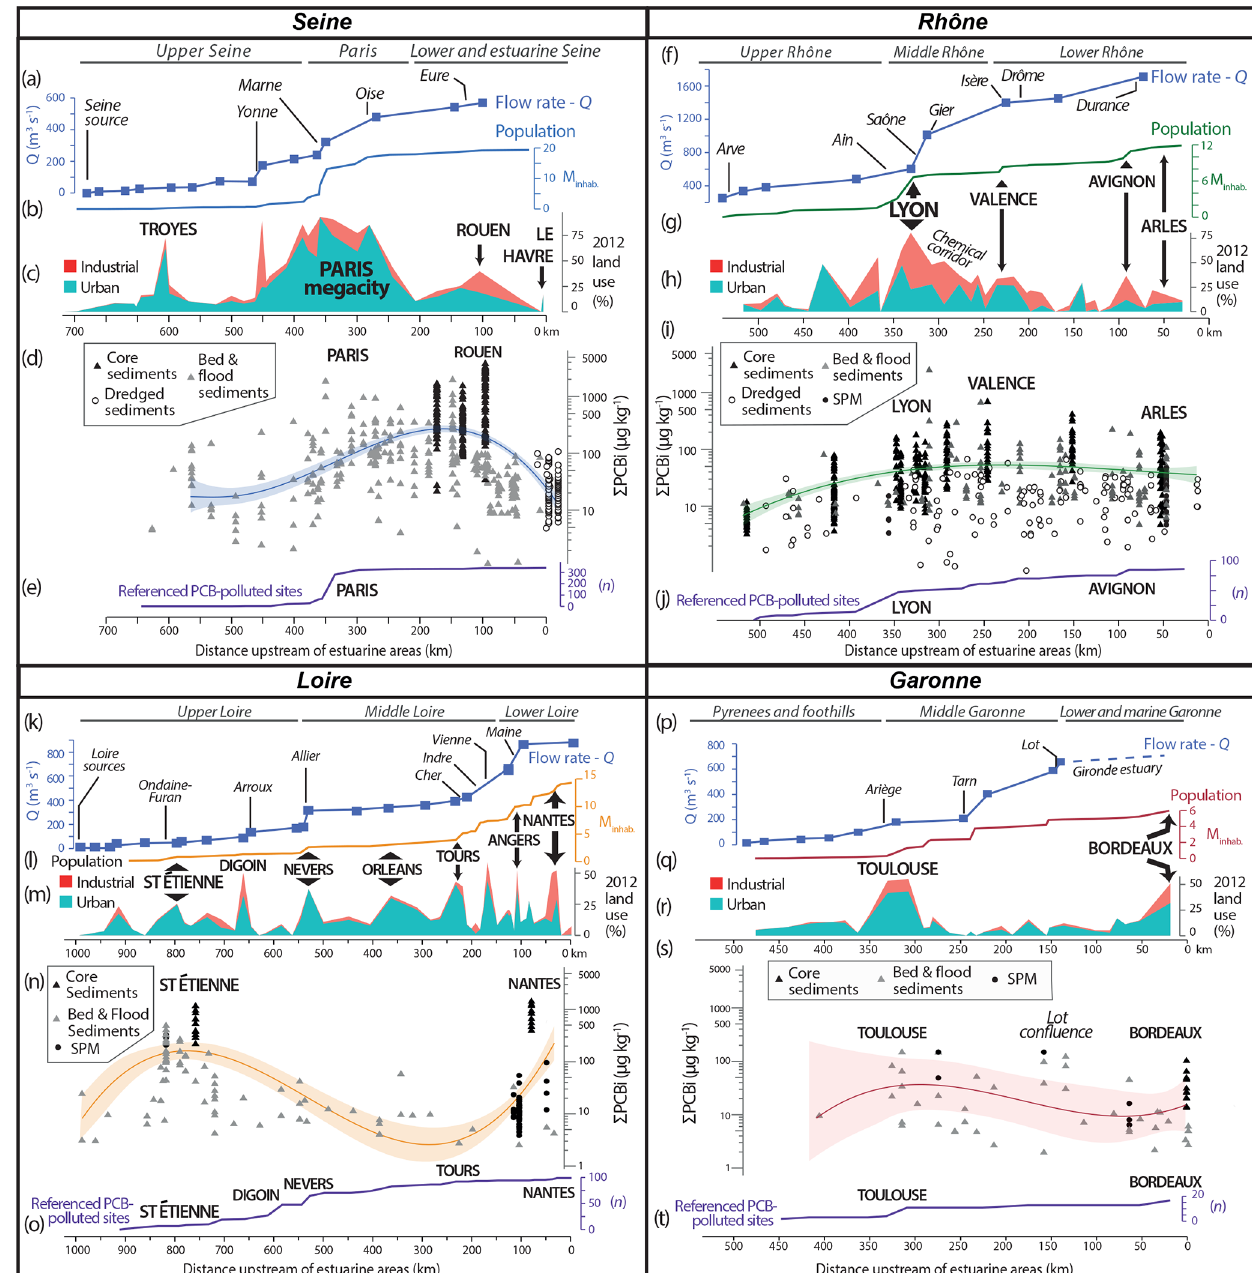
Figure 2. Main physical and socio-environmental information computed along each river corridor: (a–e) Seine, (f–j) Rhône, (k–o) Loire and (p–t) Garonne. River discharges and their main tributaries are plotted in (a) , (f) , (k) and (p) . Cumulative population in the watershed (expressed in millions of inhabitants – M inhab . ) is represented in (b) , (g) , (l) and (q) . The main urban and industrial areas within 1km of the riverbed are shown with stacked area charts in (c) , (h) , (m) and (r) . (cid:54) PCBi in solid matrices are plotted all together according to a GAM to represent the spatial variability in the PCB stocks during the period 1945–2018 ( d , i , n and s ). PCB-polluted sites referenced by the BASIAS and BASOL databases are represented by a curve cumulating the number of sites in the downstream direction ( e , j , o and t ). The distance scale is expressed in kilometres upstream of estuarine areas